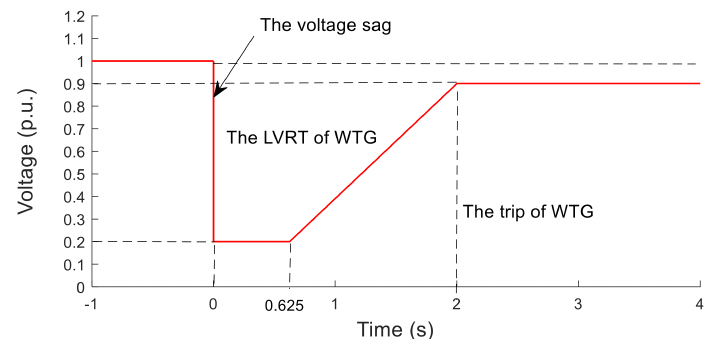
Figure 1. The grid codes of China.